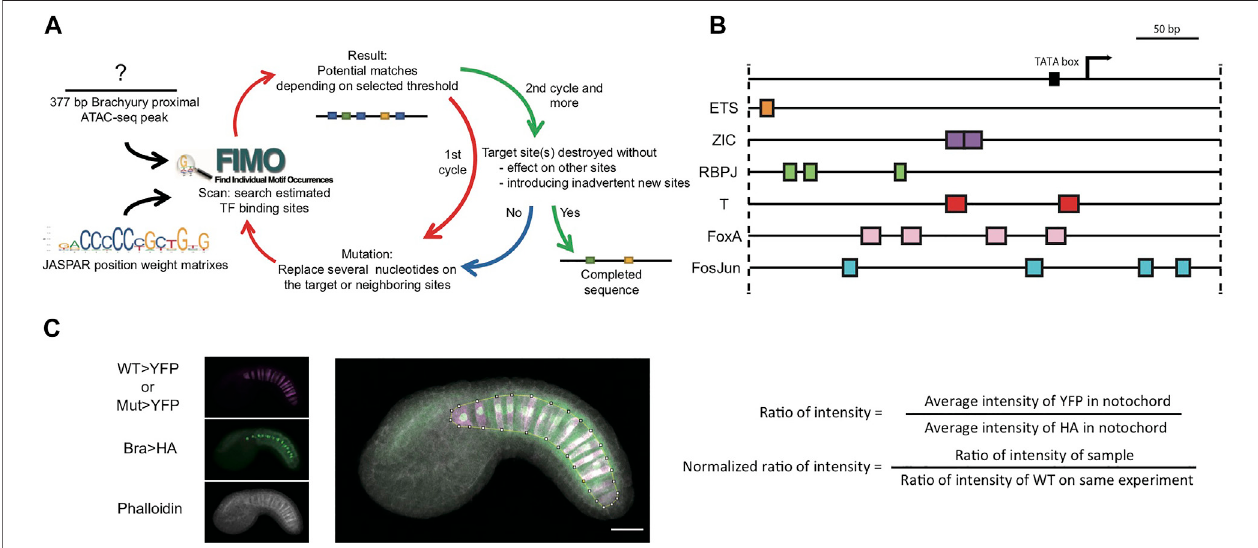
FIGURE 1 | Systematic TFBS mutation and quantitative reporter analysis for the proximal brachyury enhancer. (A) Flowchart for TFBS prediction and mutation design. Black arrows, initial input. Red arrows, procedure for fi rst cycle. Green and Blue arrow, second cycle and decision for completion of mutated sequence. (B) Diagram of predicted TFBSs on bra 377-bp promoter/enhancer. Arrow: endogenous bra transcription start site. The plasmid vector also contains its own bpFOG basal promoter. Colored boxes: predicted TFBSs. (C) Dual reporter image acquisition and analysis strategy. The YFP reporter channel is shown in magenta, and the Bra > H2B:HA internal control channel in green. Phalloidin staining is in greyscale. The overlayed projection is marked with a Region of Interest around the notochord.